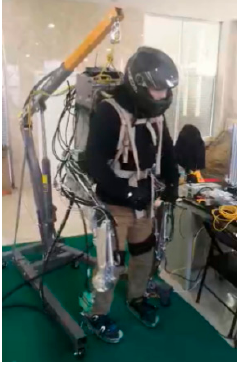
Figure 27. Load test. Table 4. Data for load test.